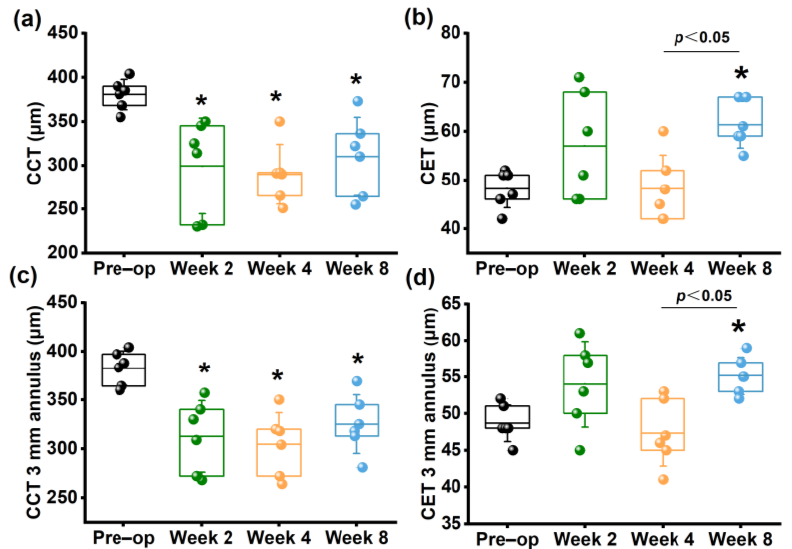
Figure 6. Changes in morphologic parameters measured by SD-OCT. ( a ) CCT; ( b ) CET; ( c ) CCT 3 mm annulus; ( d ) CET 3 mm annulus. * p < 0.05 vs. preoperative group.